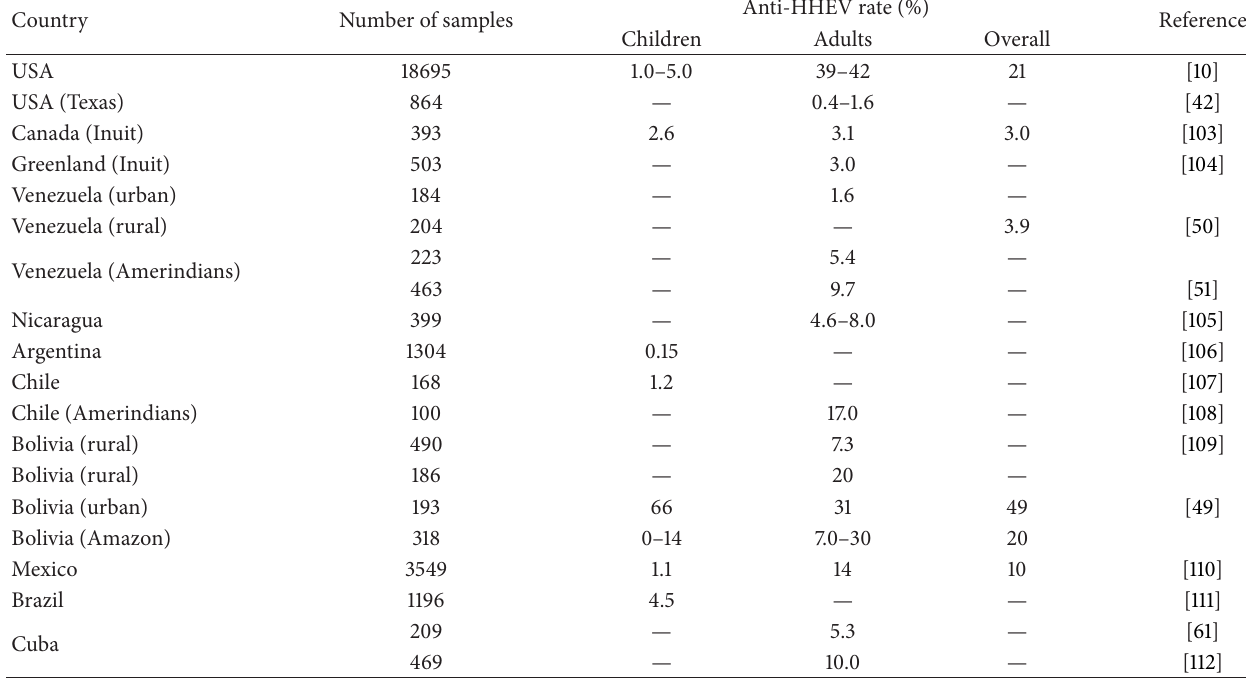
Table 4: Prevalence of anti-HHEV among the general population of the